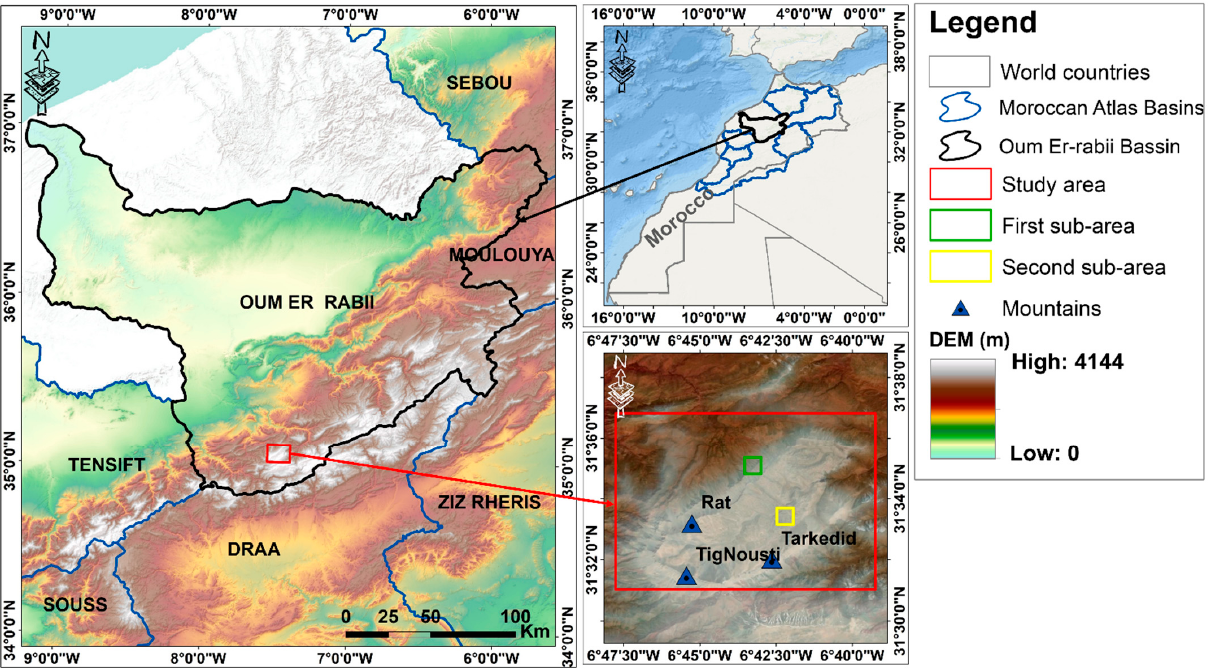
Figure 1. Maps showing the location of the study